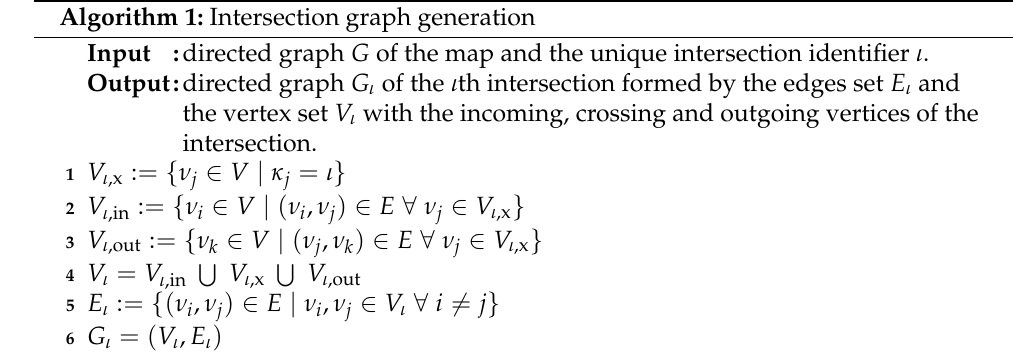
Algorithm 1: Intersection graph generation